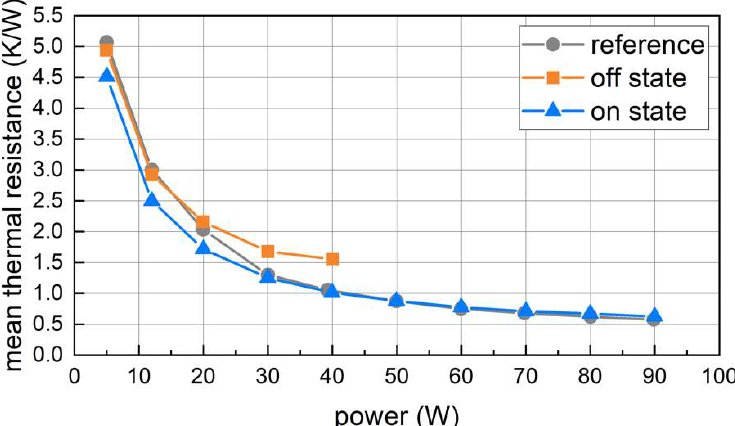
Figure 4. Experimentally obtained mean thermal resistance curves for reference thermosiphon and switchable thermosiphon in on and off state.